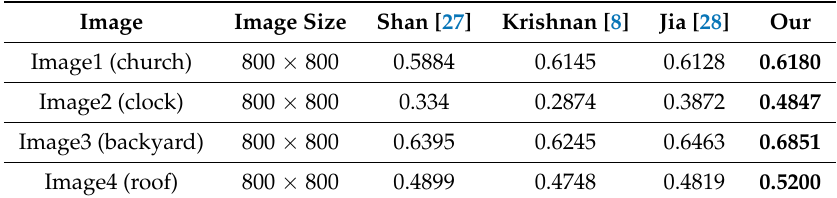
Table 2. Comparison on four images from a real-world benchmark dataset. SSIM values of the debluring images by different methods.